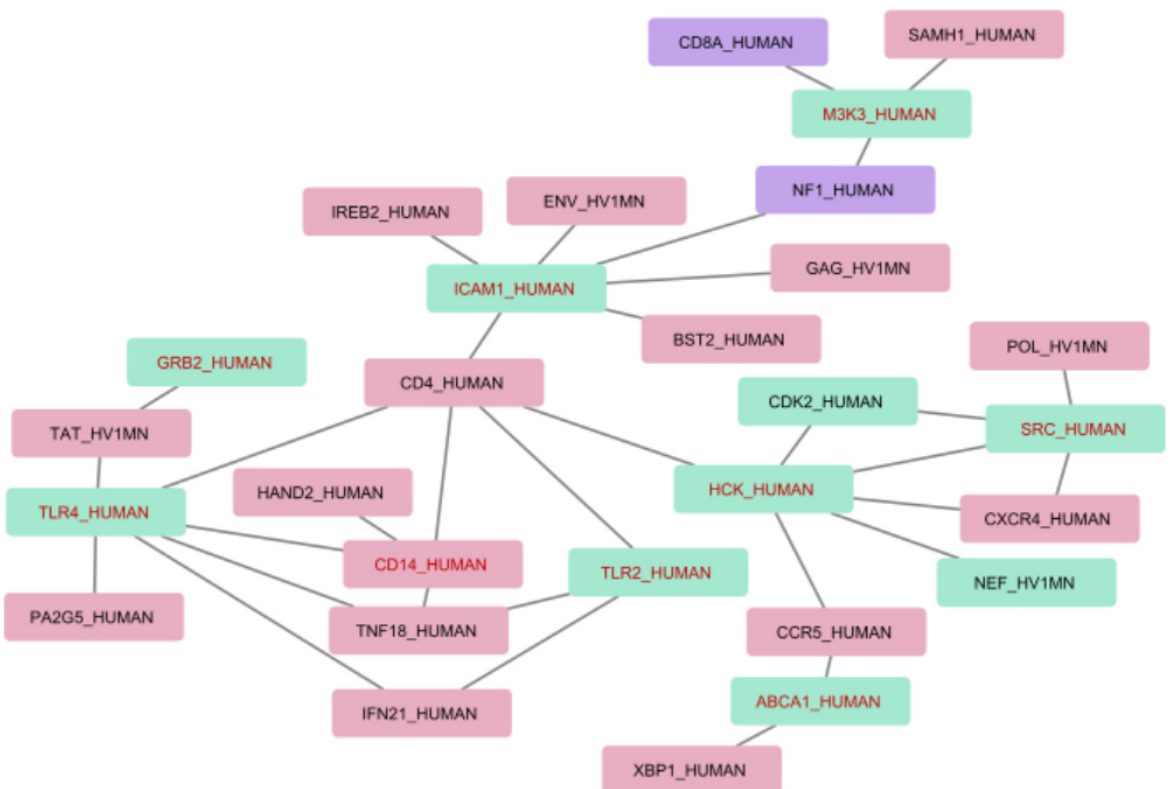
Figure 3. Interaction map including differentially expressed genes. Red nodes represent protein associations which were extracted only from HIV-host text collection; green nodes represent protein associations which were extracted from both HIV-host and HIV progression text collections; and purple nodes are for the associations in HIV progression text collection only. Red font is used to mark differentially expressed genes.